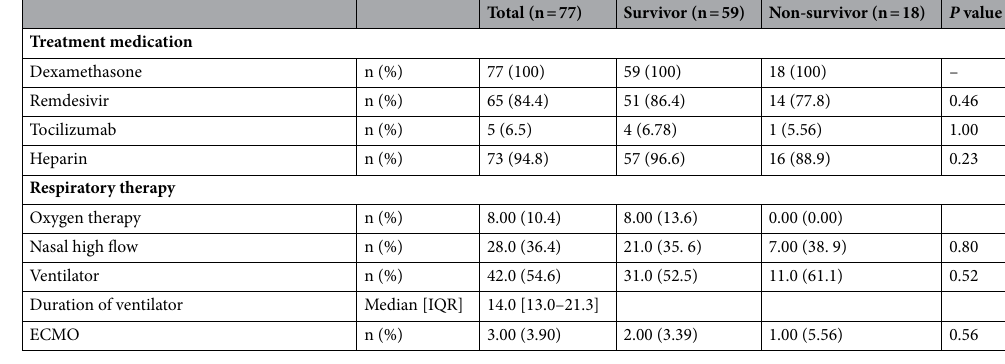
Table 1. Patient characteristics. P < 0.05 indicates a significant difference. COPD chronic obstructive pulmonary disease, BA Bronchial asthma, CHF congestive heart failure, NYHA New York Heart Association,